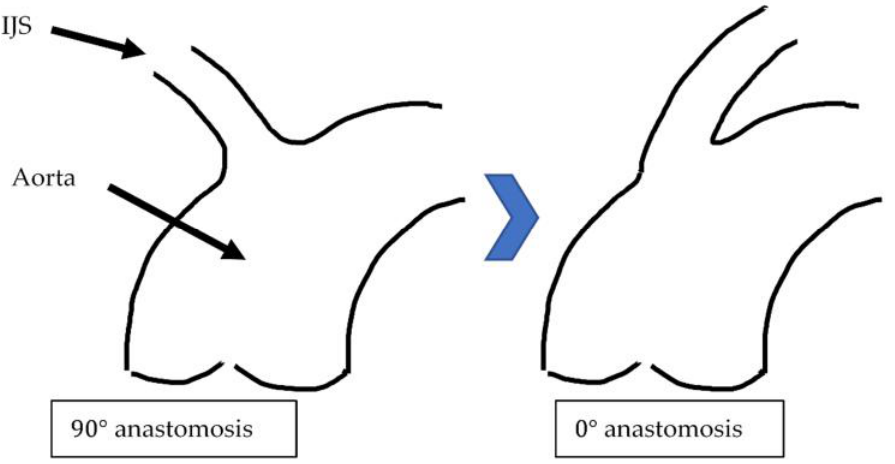
Figure 10. IJS proximal anastomosis angle.